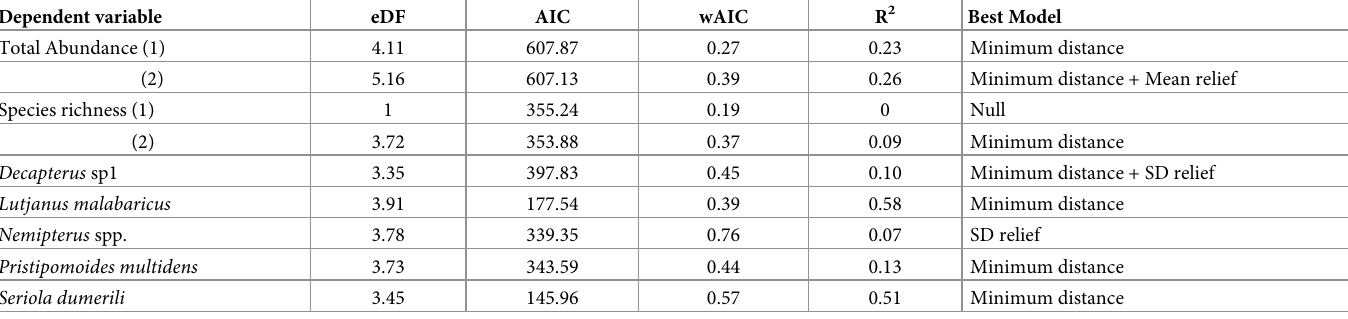
Table 5. Generalised additive models (GAMs) for predicting total abundance, species richness, and the abundance of key species in deep water stereo-BRUV deploy- ments within 2 AIC of the top model. Dependent